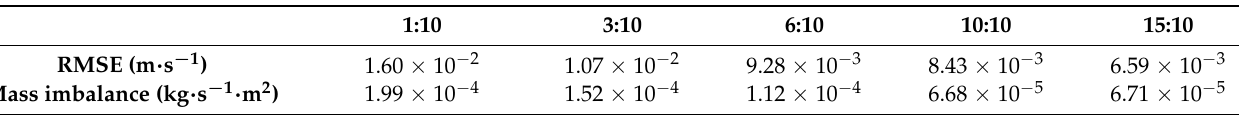
Table 5. FNO errors for predicting ten timesteps in advance, for several input time window sizes, after a maximum of 300 epochs.